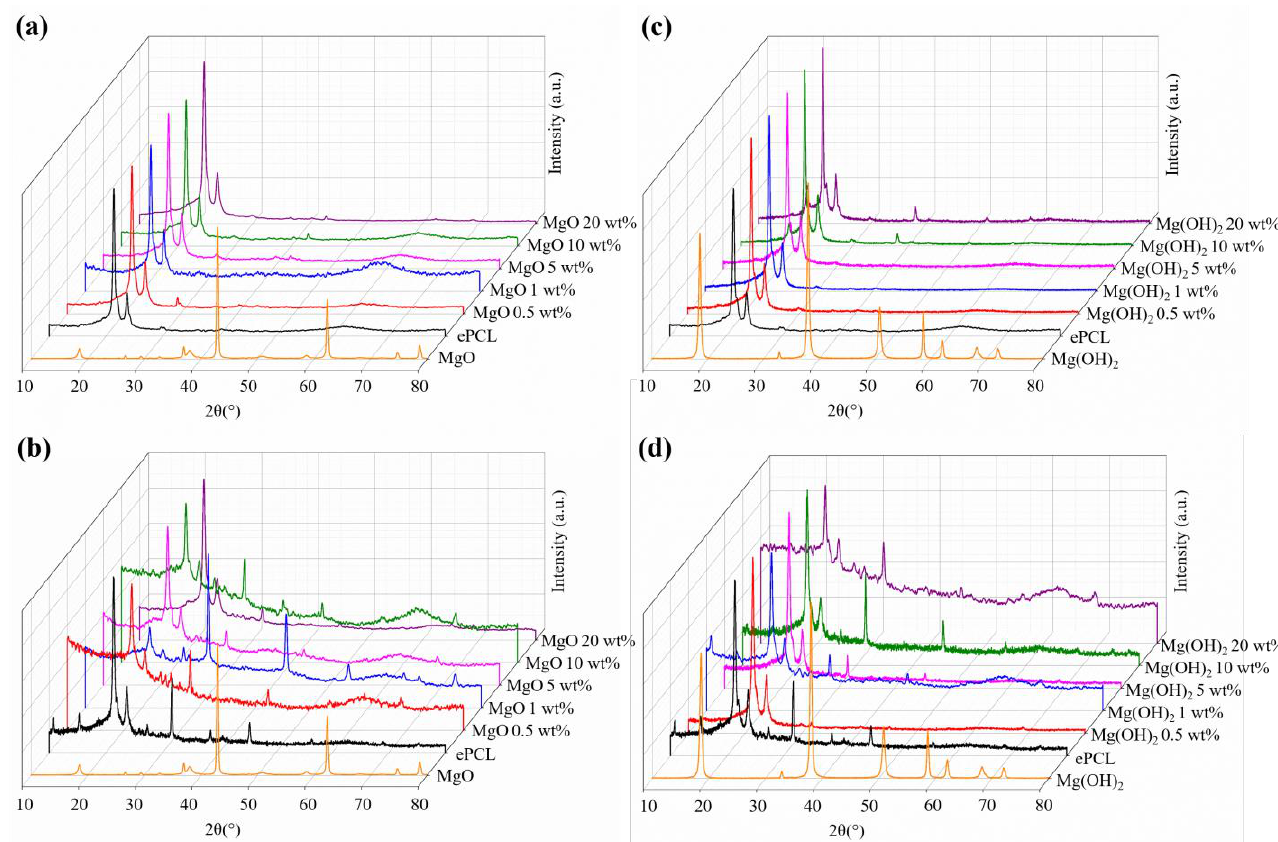
Figure 14. XRD patterns of ( a ) ePCL + MgO NPs at T0, ( b ) ePCL + MgO NPs at T28, ( c ) ePCL + Mg(OH) 2 NPs at T0 and ( d ) ePCL + Mg(OH) 2 NPs at T28 in SBF